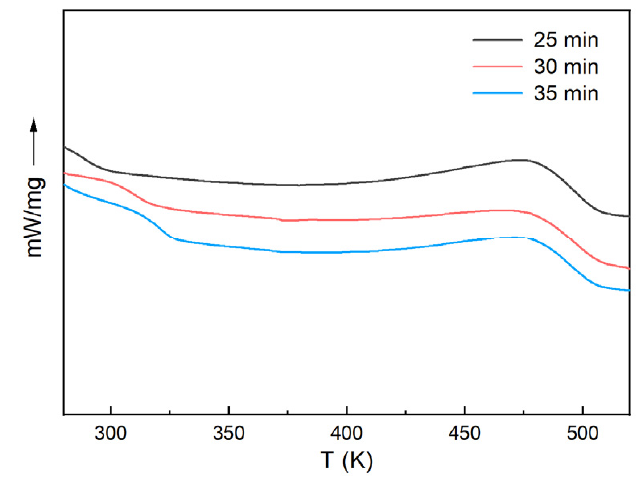
Figure 5. DSC curves of the H 6 XDI/BES system after incubation at 423 K for different times. Figure 7 indicates that the area of the exothermic peaks decreased with the increase in cure time. The residual enthalpy decreased, and the glass transition temperature increased with increasing conversion, characteristic of the H 6 XDI/BES system. There was a baseline shift in all the curves at a temperature below 323 K. The corresponding temperature was lower than the Tg ∞ , indicating that the curing of the system was incomplete. This was also reflected by the exothermic peak at 473 K. The isothermal DSC curves were analyzed according to Equation (15), the results of which are listed in Table 2. Table 2. DSC data based on Figure 7. Incubation Time